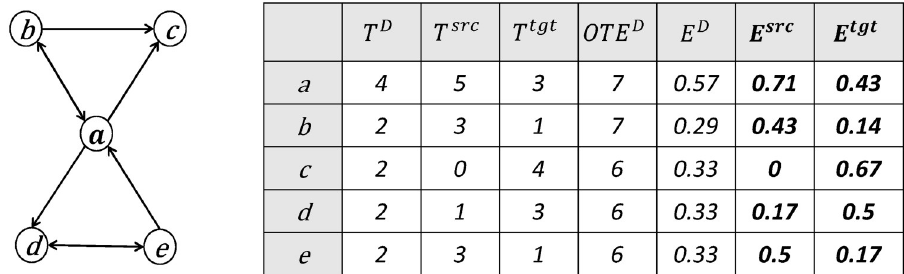
Fig 4. An example of calculating the source closure coefficient and target closure coefficient.